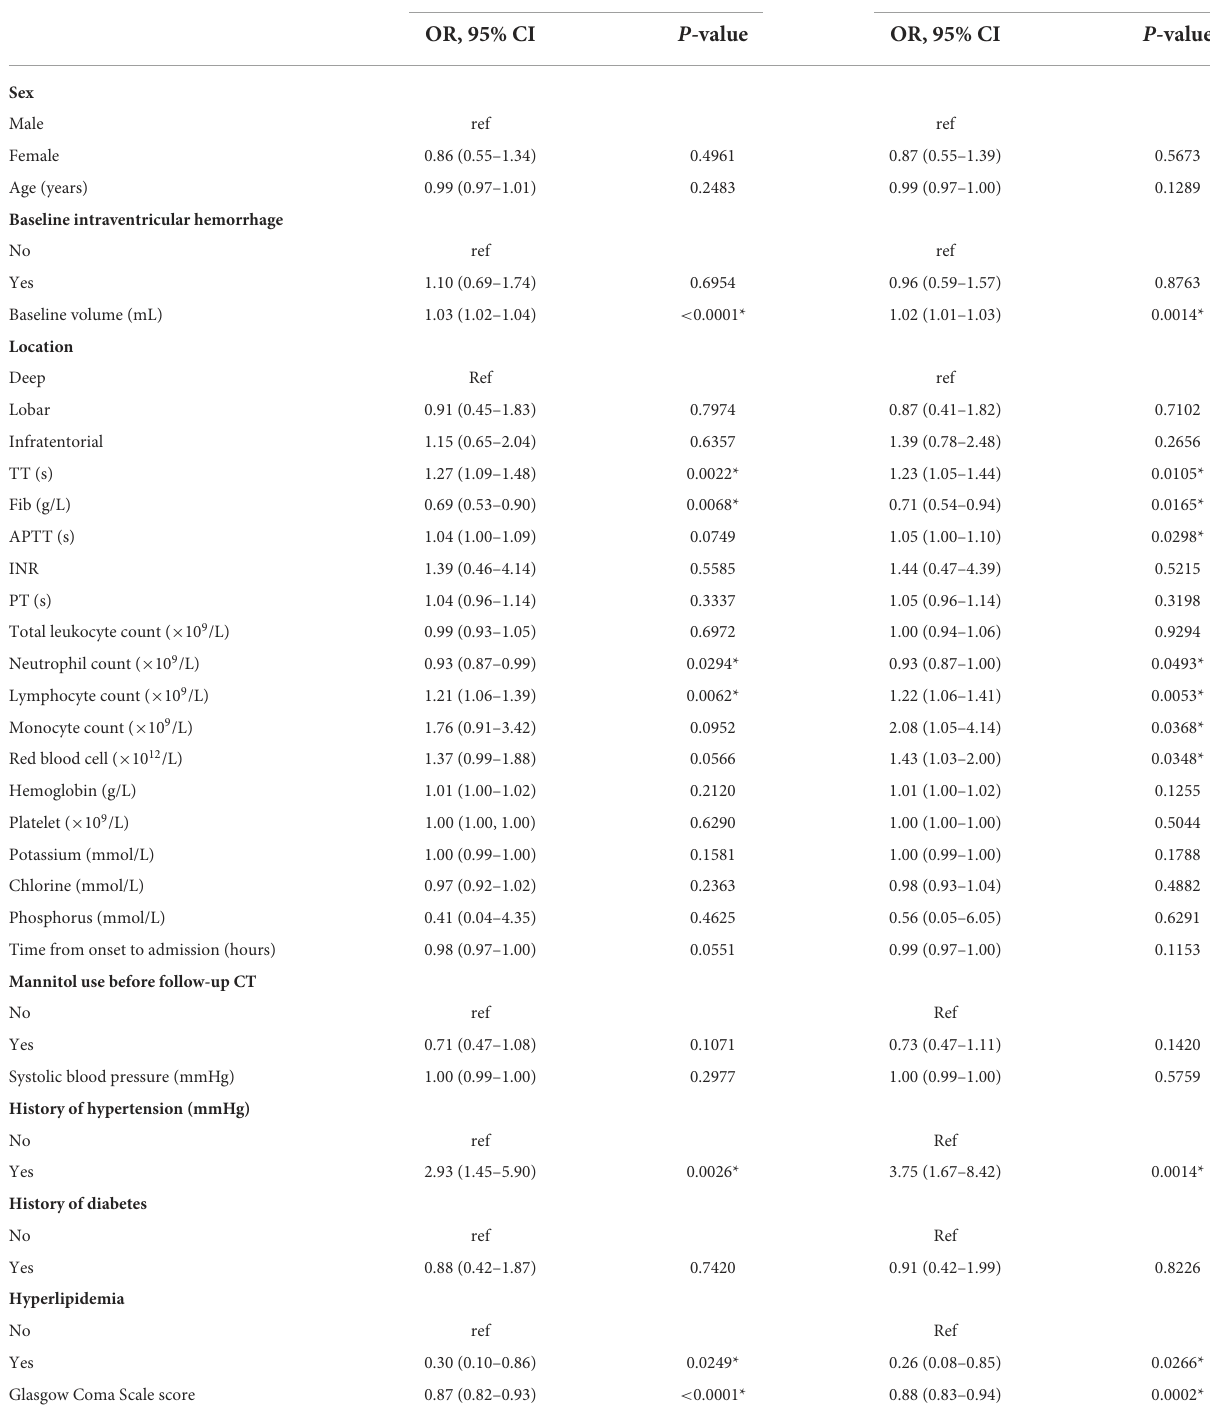
TABLE 2 Univariate analysis of hematoma expansion (HE) based on two